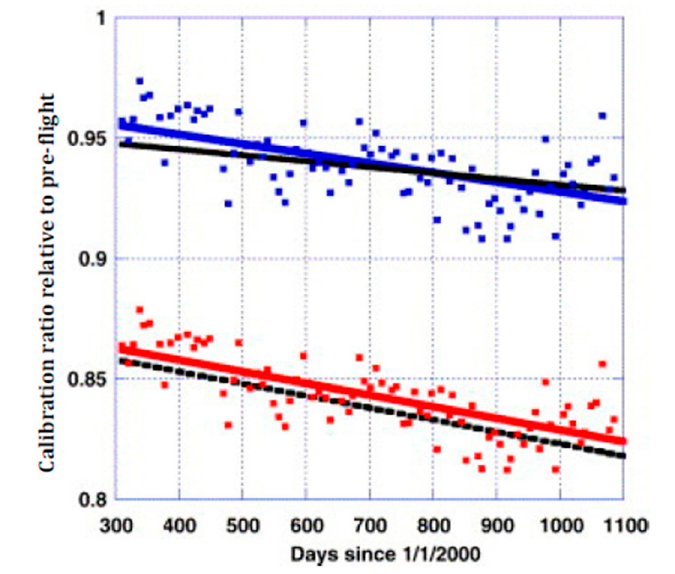
Figure 3. Comparison of the NOAA16-AVHRR/MODIS Terra cross calibration over desert sites for band 1 (black solid line) and band 2 (black interrupted line), with the trends obtained using the ocean and clouds method [2] for band 1 (blue line and square) and band 2 (red line and square) (from [3]).